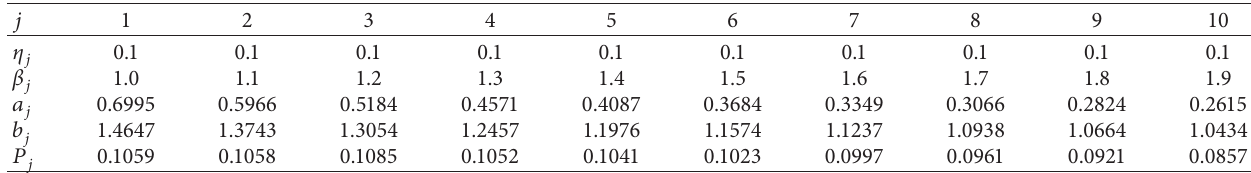
Table 2: The hyperparameter values.